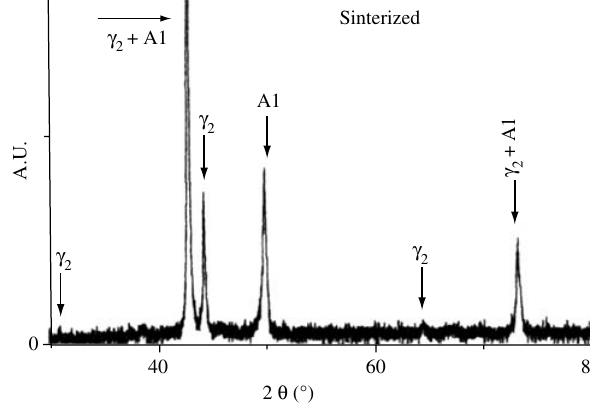
Figure 1. X-ray diffractograms of powder milled for different times at 150 rpm without a lubricant.